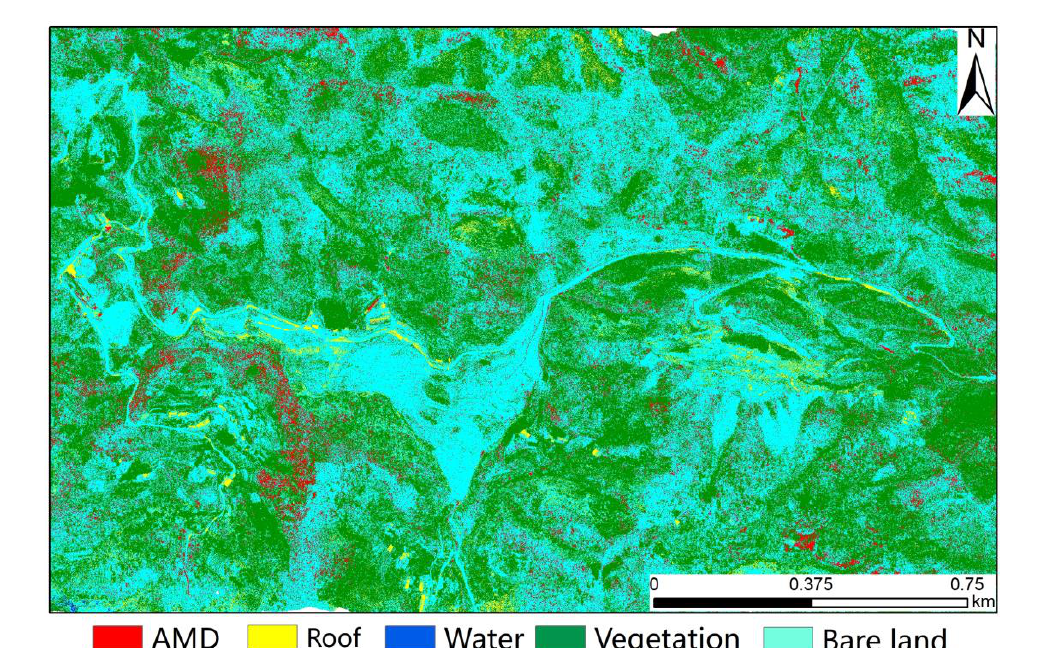
Figure 8. The classification map of RF method.